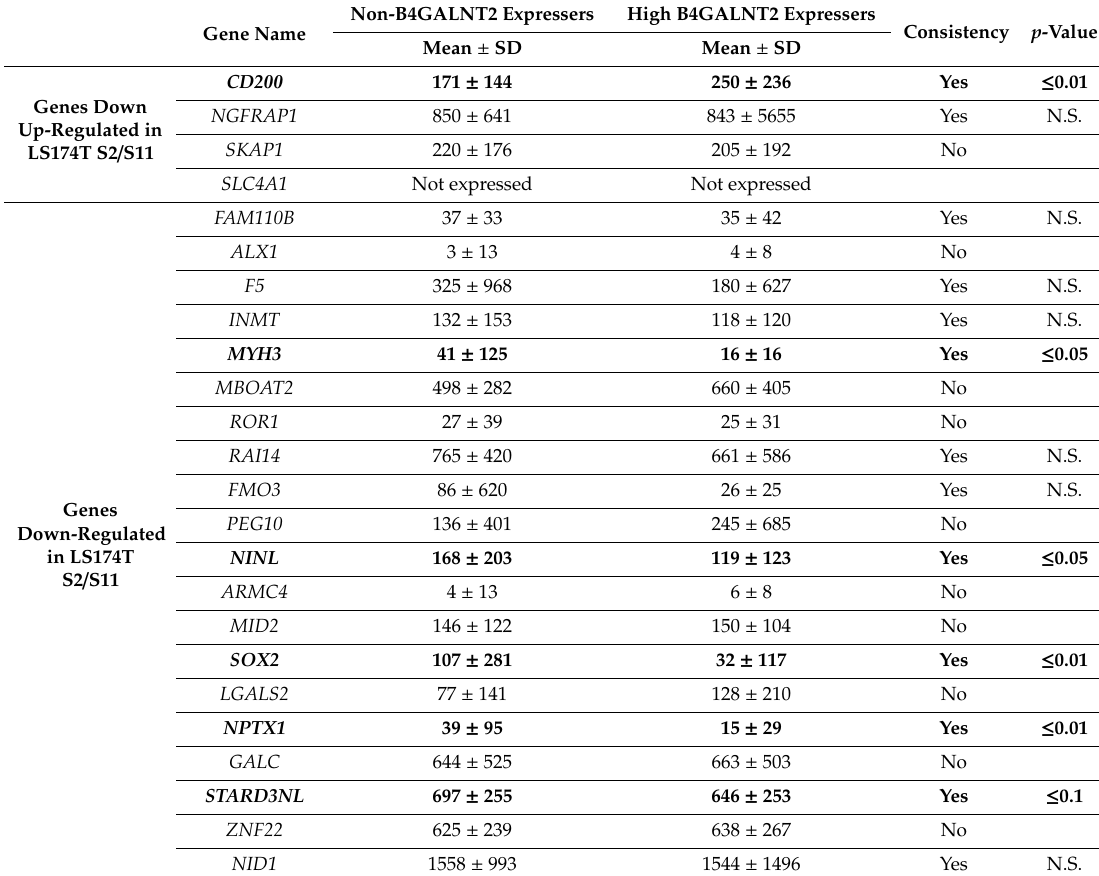
Table 4. Gene expression comparison between TCGA cohort (Non- and High B4GALNT2 expressers and microarray analyisis of LS174T cells (S2 / S11 comparison with